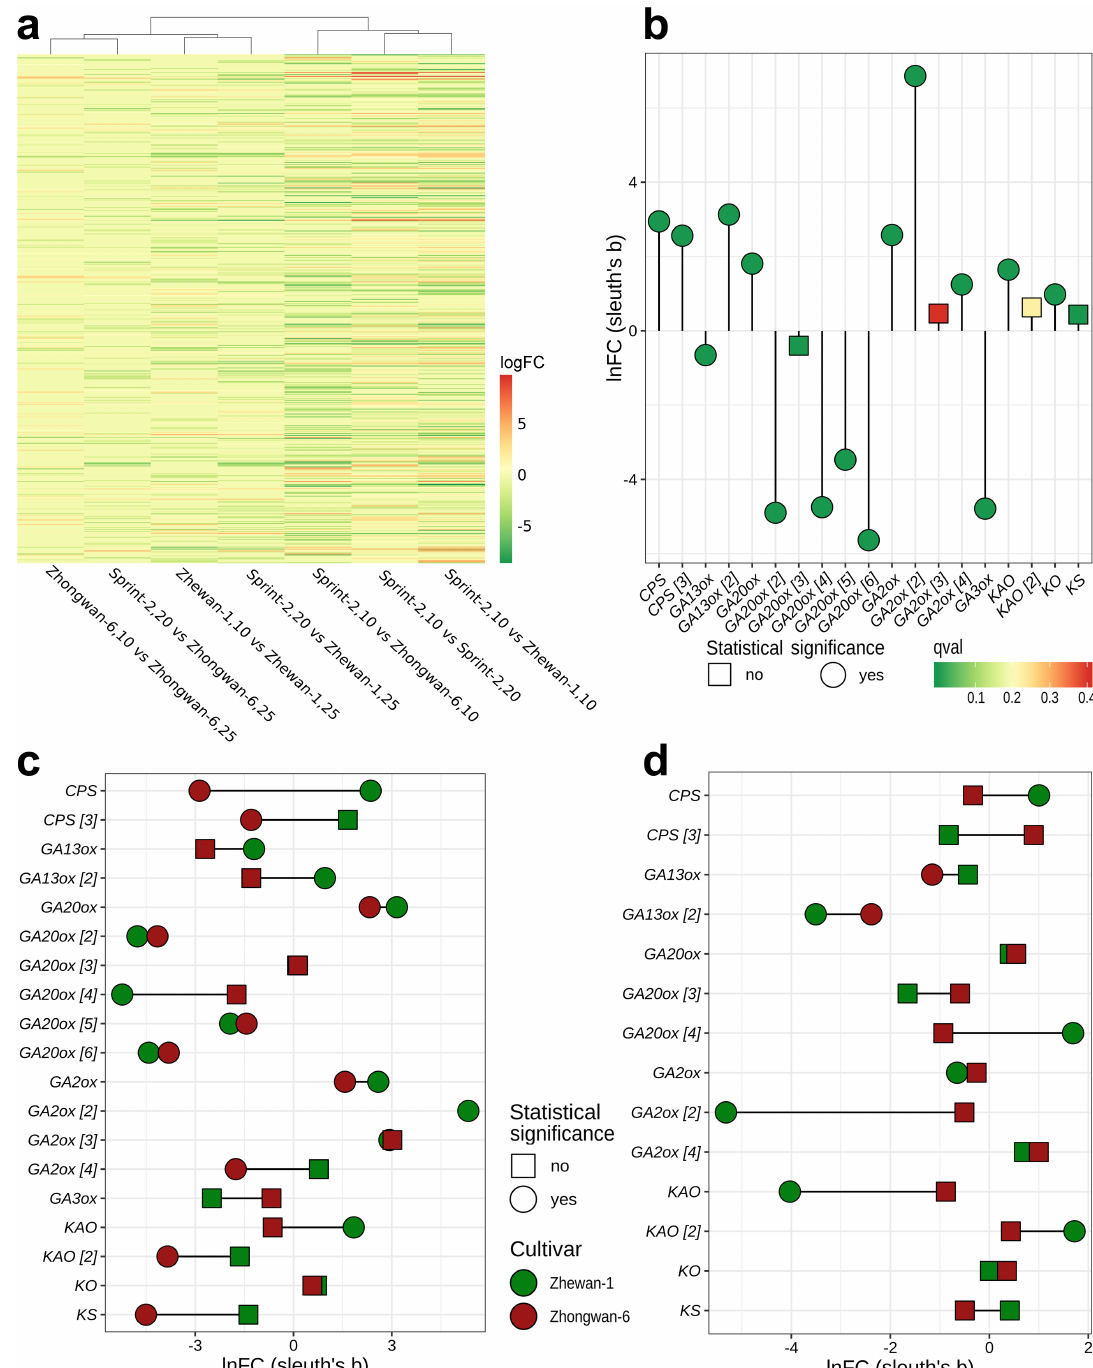
Figure 10. Expression dynamics of transcripts related to phytohormone biosynthesis. ( a ) Heatmap of expression changes in di ff erent comparisons. Plotted are logFC changes in the respective comparisons, where clustering was performed using Euclidean distances between samples. ( b – d ) Expression of transcripts related to gibberelin (GA) metabolism. Numeric axis values indicate logFC changes in respective DE tests. ( b ) Changes between 10 and 20 DAP seeds of Sprint-2. ( c ) Di ff erential expression between Sprint-2 and Zhewan-1 / Zhongwan-6 seeds at 10 DAP. ( d ) Di ff erential expression between Sprint-2 and Zhewan-1 / Zhongwan-6 mature